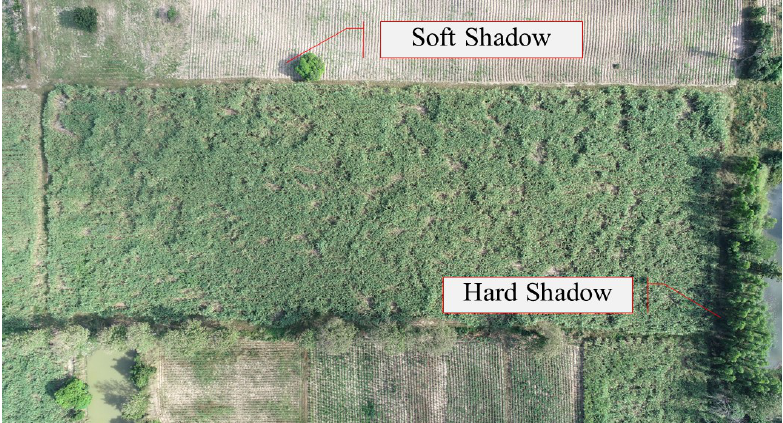
Figure 4. The top view of the sugarcane plantation image captured by the unmanned aerial vehicle (UAV).